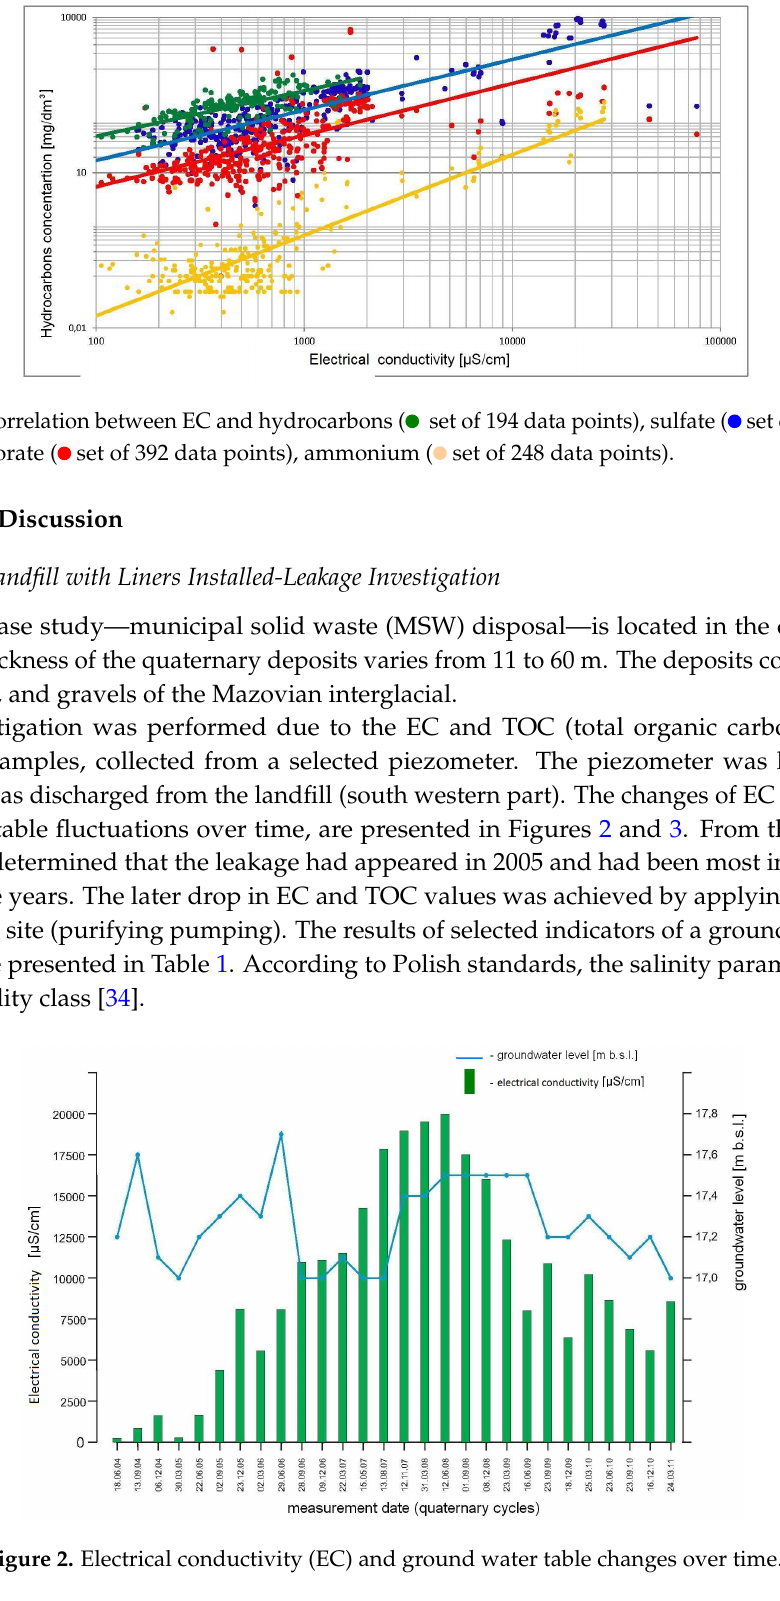
Figure 2. Electrical conductivity (EC) and ground water table changes over time.